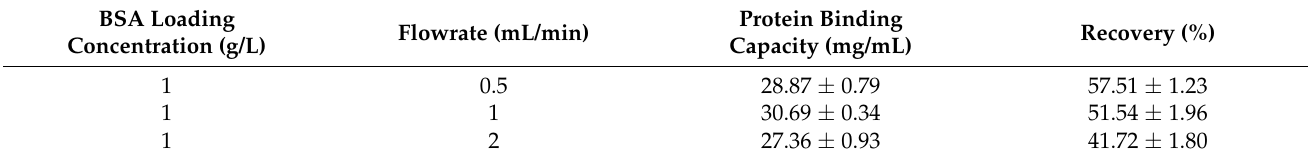
Table 4. The effect of flow rate on DBC and recovery of BSA for PVCL grafted with 80 mM initiator and 6 h ATRP.